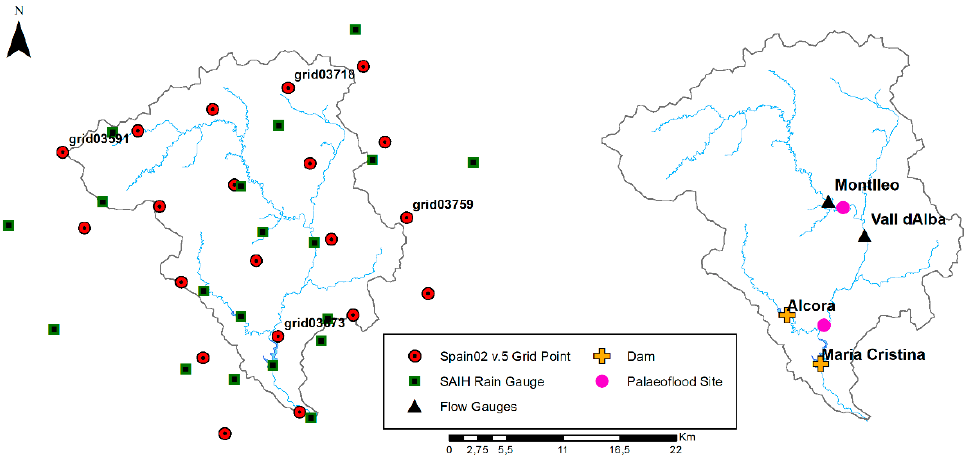
Figure 2. Location of hydrometeorological information.